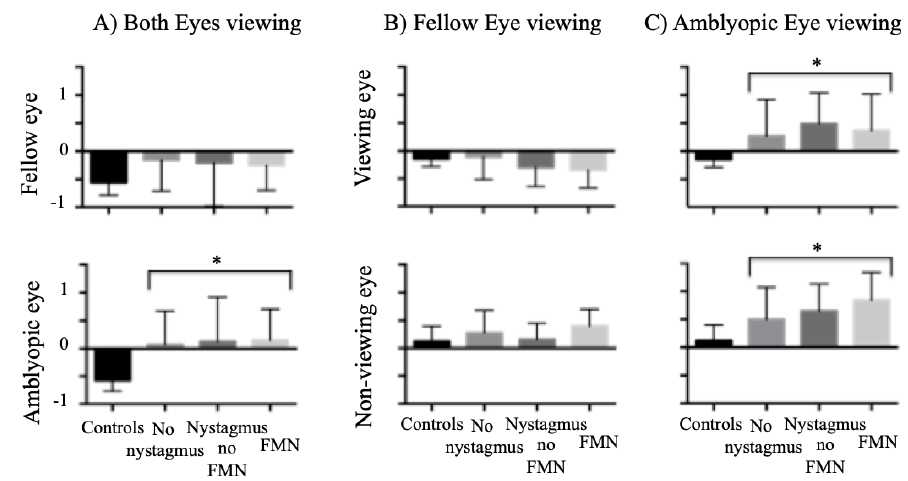
Fig. 3 : Mean and standard deviation of BCEA values in subjects categorized by fixation eye movement waveforms. Under both eyes viewing condition (A), the amblyopic eye had less stable fixation (positive values) compared to con- trols (negative values) irrespective of the waveform type. Under fellow eye viewing condition (B), no differences were seen in the viewing and non-viewing eye between controls and amblyopic patients. Under amblyopic eye viewing con- dition (C), the BCEA values were greater in both the viewing and non-viewing eye. *=p<0.05, one way ANOVA